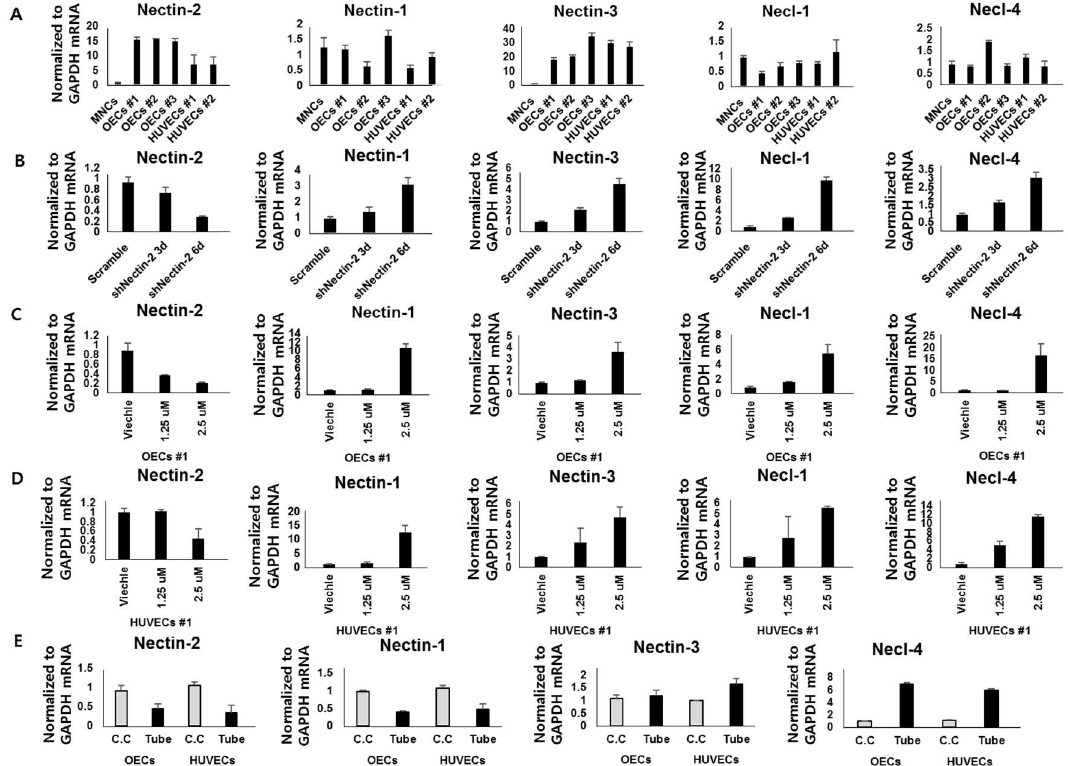
Fig 5. Compensation of Nectin-2 function by other Nectin family members and related genes. (A) Expression of the Nectin family genes Nectin-1, 2 and 3 and the related genes Necl-1 and Necl-4 was measured by real-time RT-PCR in MNCs, OECs and HUVECs. (B) Nectin-family and related gene expression levels were tested in Nectin-2-knockdown OECs. (C) Nectin-2 mRNA levels were assessed 24 hrs after CdCl 2 treatment in OECs and (D) in HUVECs. (E) OECs were cultured in Matrigel for 24 h, and the resulting tube-forming OECs were harvested and evaluated for Nectin and Nectin-like molecule expression ( P <